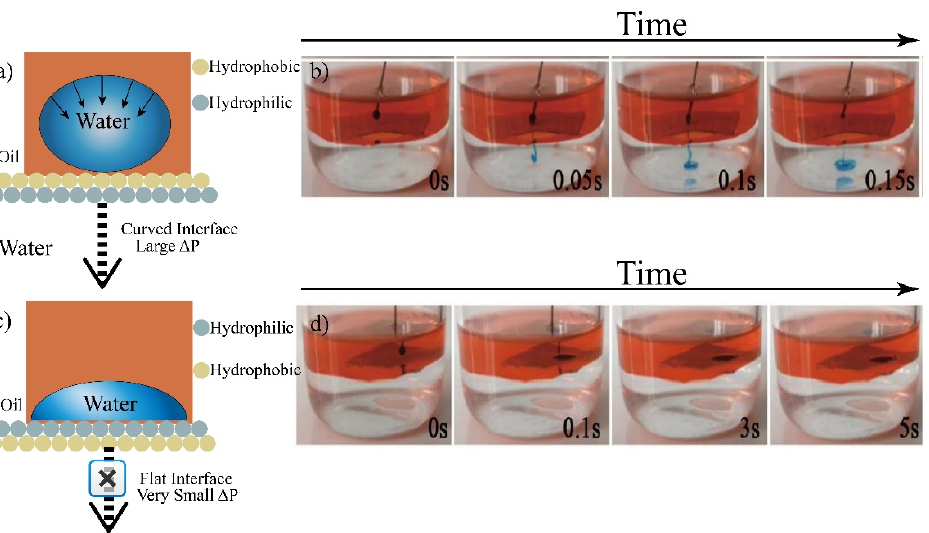
Figure 8 . Unidirectional water droplet penetration across Janus paper (300 μ m) in the oil–water system. ( a , b ) For positively aligned Janus paper, a water droplet touching the superhydrophobic side exerts a larger Laplace pressure (P L ), creating a larger driving force for penetration. ( c , d ) For reversely aligned Janus paper, a water droplet seated on the superhydrophilic side tends to spread, exerting a smaller P L ; therefore, the oil-infused layer can block its penetration.